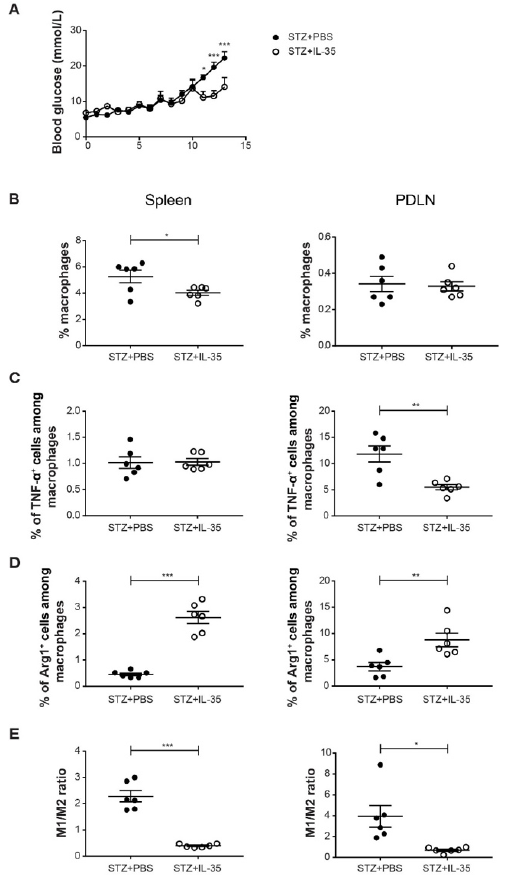
Figure 5. IL-35 treatment reduced the M1/M2 ratio in STZ mice. Male CD-1 mice were injected intraperitoneally with low doses of STZ (40 mg/kg body weight) for 5 consecutive days. For the next 8 days, mice were injected daily with PBS or recombinant mouse IL-35 (0.75 µ g/day). Blood glucose levels of the mice were measured every day from day 5 after the first STZ injection ( A ). The mice were killed on day 13. Single cells were prepared from harvested PDLNs and spleens. ( B ) The proportions of macrophages. ( C ) The proportions of TNF- α + cells among macrophages. ( D ) The proportions of Arg1 + cells among macrophages. ( E ) M1/M2 ratio. Results are expressed as means ± SEM. Repeated two-way ANOVA followed by Sidak’s test and unpaired t -tests were performed for comparisons. *, ** and *** denote p < 0.05, p < 0.01 and p <